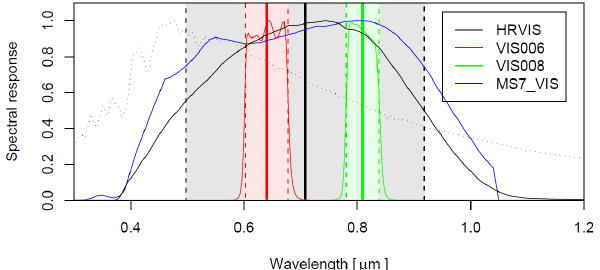
Fig. 1. Normalized spectral response functions of the Meteosat-9 SEVIRI radiometer for the 0.6µ m (red),